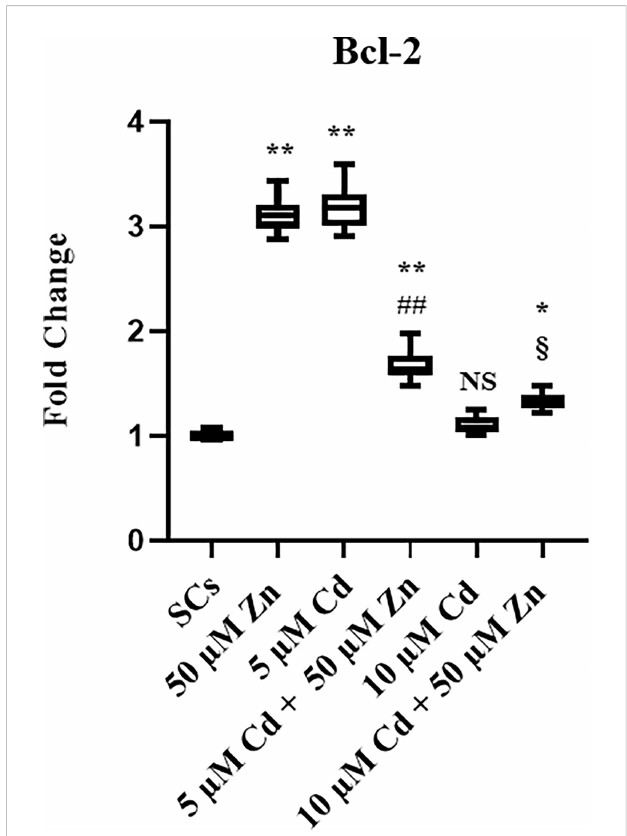
FIGURE 5 Real-Time PCR analysis of Bcl-2. Gene expression of Bcl-2 in the absence (unexposed-control group, SCs) or presence of 5 or 10 µM CdCl2 and/or 50 µM ZnCl2 for 48 h. Data represent the mean ± S.E.M. (Not signi fi cant, NS). NS vs SCs, *p < 0.05 and **p < 0.001, ##p < 0.001 vs 5 µM Cd, §p < 0.05 vs 10 µM of three independent experiments, each performed in